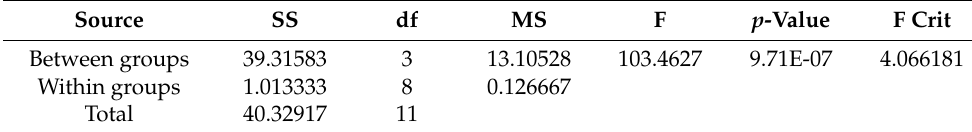
Table 6. Analysis of variance results for influence of working speed on weeding rate. Source